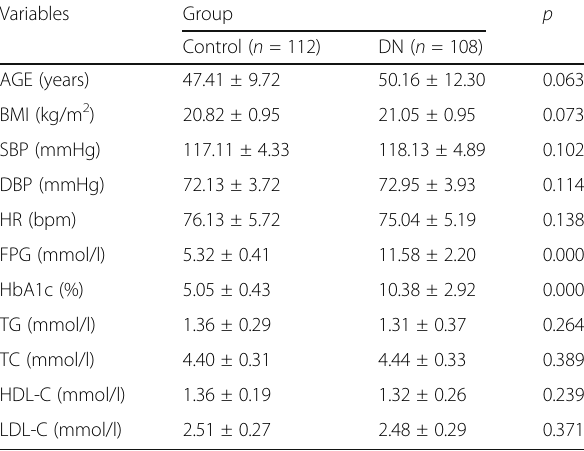
Table 1 Comparison of clinical evaluation and biochemical test Variables